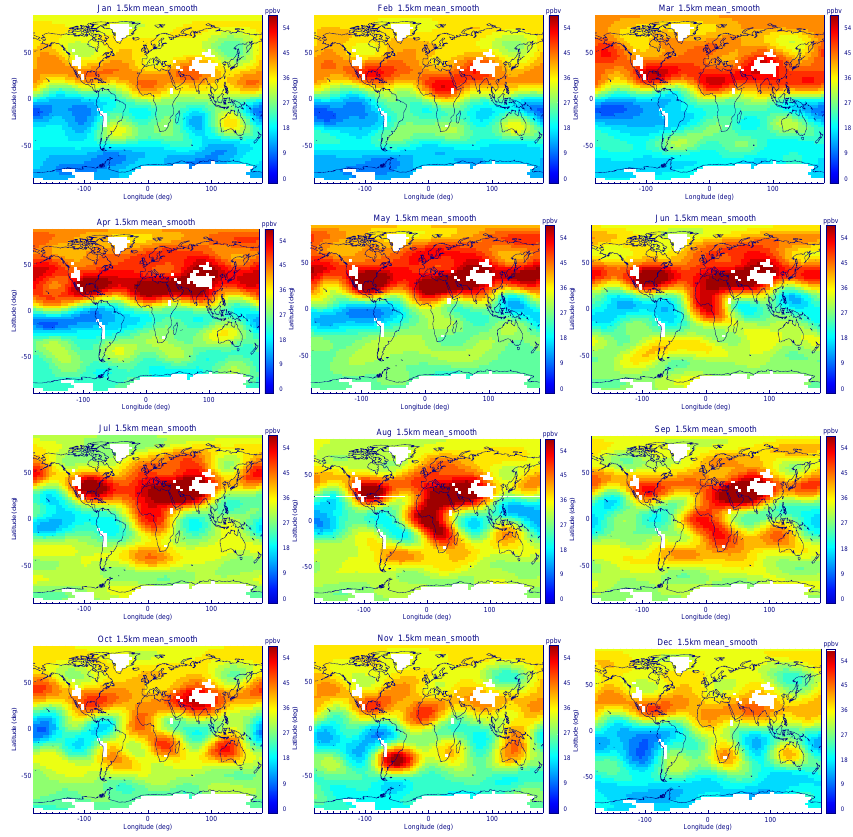
Fig. 6. Global ozone distributions at 1.5km above sea level for all months. The trajectory-mapped results have been smoothed and further interpolated. Data from 1980 to 2008 are Figure 6: Global ozone distributions at 1.5 km above sea level for all months. The trajectory mapped results have been smoothed and further interpolated. Data from 1980-2008 are used.